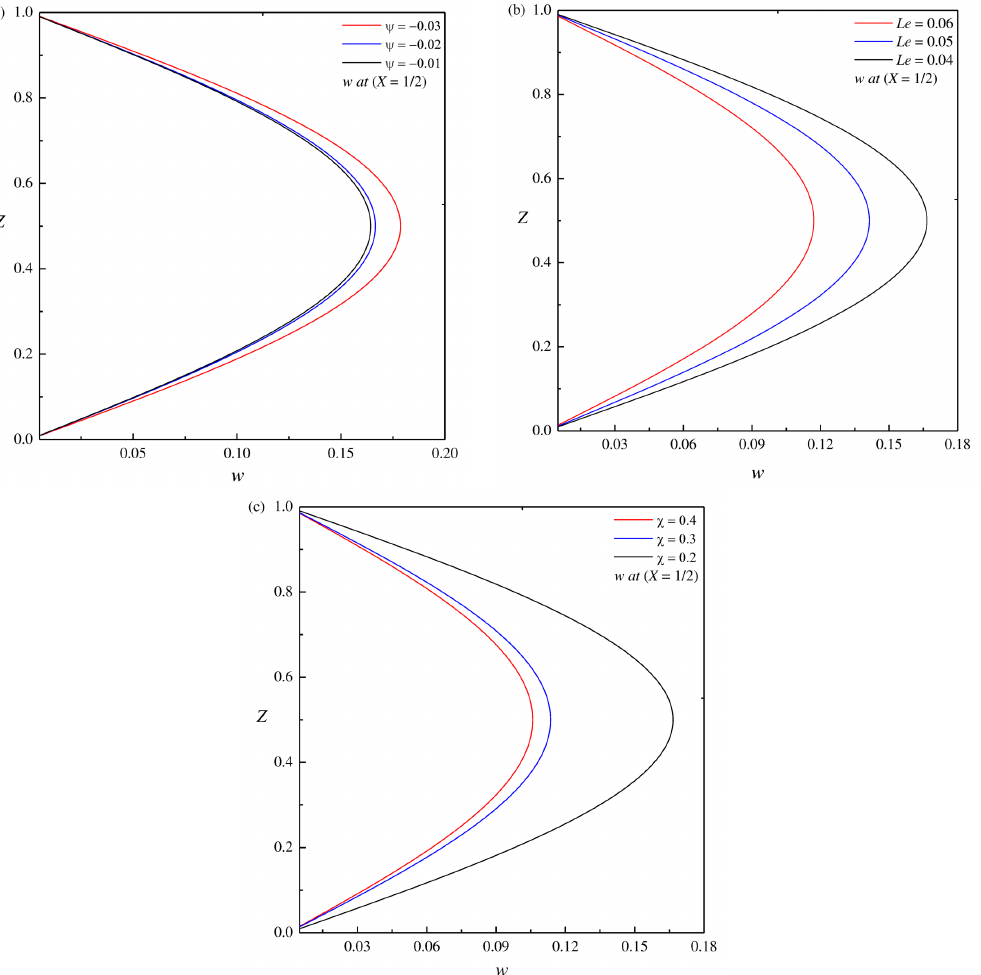
Figure 3. Solutions of Z -direction velocity component ( w ) profile against Z-direction at R = 3 R co and t = 0.1 for ( a ) Le = 0.04, χ = 0.2 for different ψ , ( b ) ψ = − 0.03, χ = 0.2 for different Le , ( c ) ψ = − 0.03, Le = 0.04 for different χ